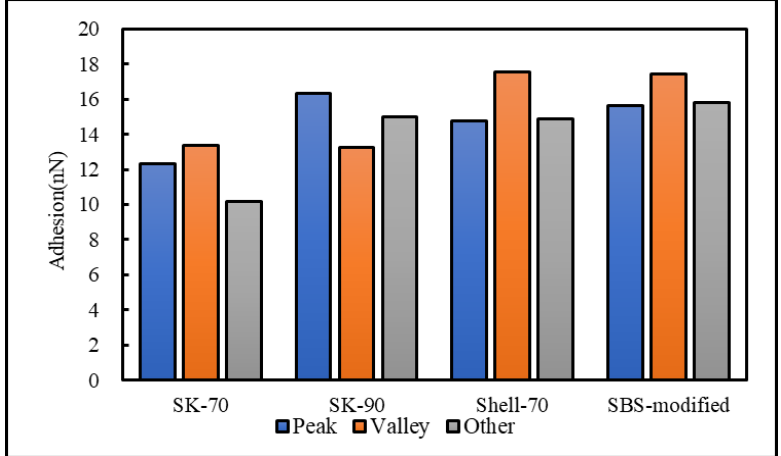
Figure 10. Adhesion between the probe and original asphalt in different regions. Table 4. The overall surface energies and adhesion forces between the probe and